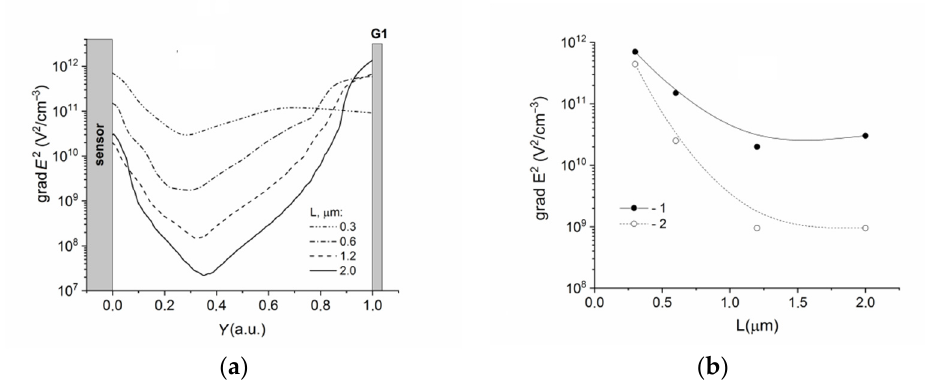
Figure 7. ( a ) Dependencies of grad E 2 ( Y ) calculated in the cross sections of B for DEP-2 sensors with different distances L to electrode G1. V bg = 0.5 V. ( b ) Dependencies of grad E 2 ( L ) calculated at Y = 0 ( a ) and V bg , V: (1) − 0.5 and (2) − 0.5. Z = 30 nm, H G = 100 nm.